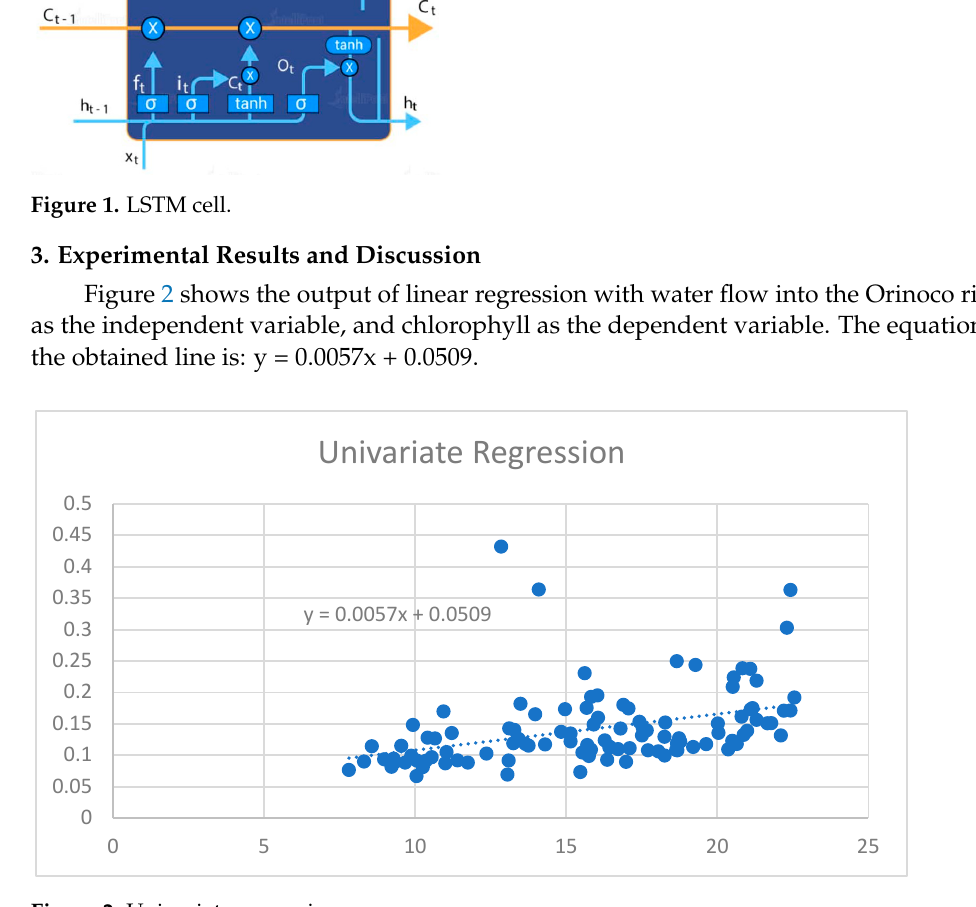
Figure 2. Univariate regression.